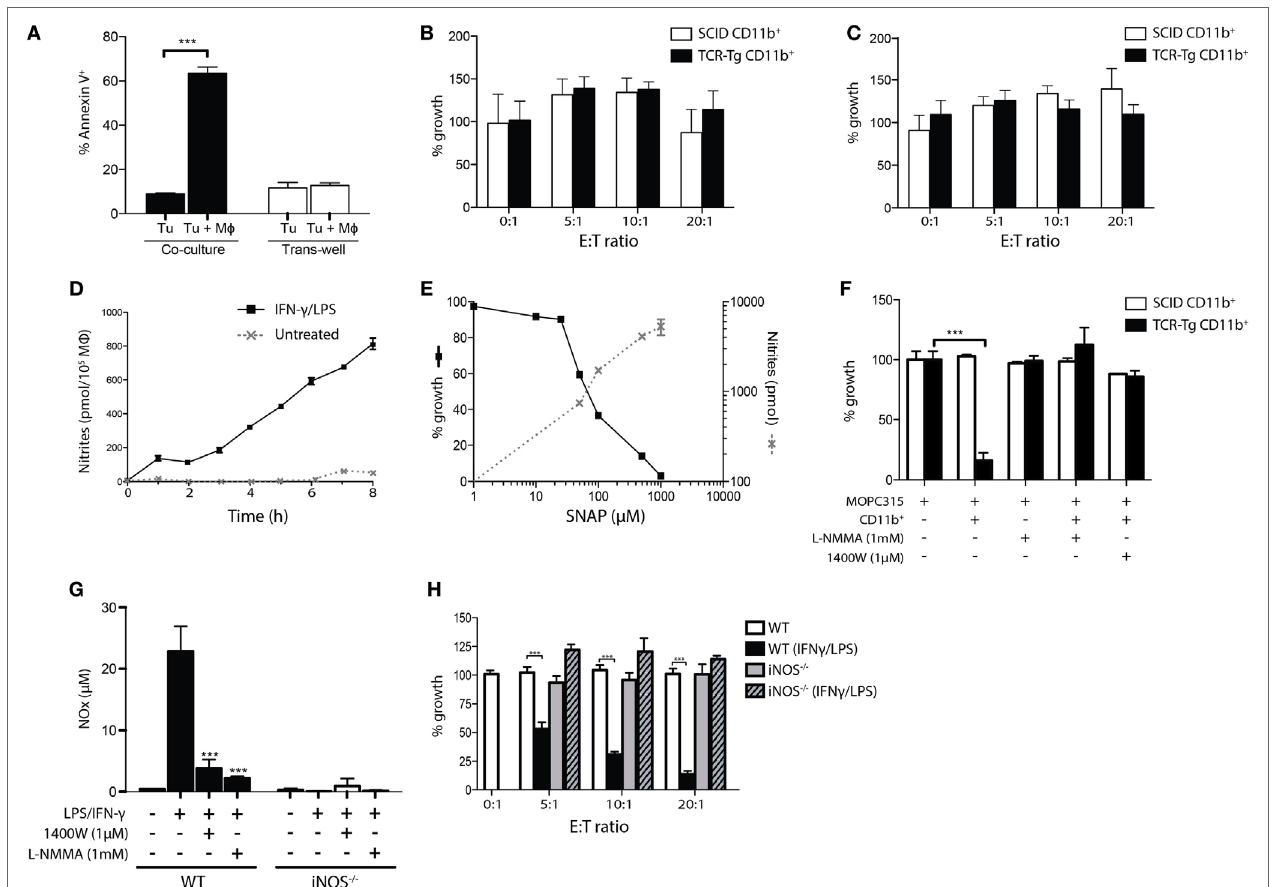
FigUre 2 | Killing of myeloma cells by activated macrophages is dependent on inducible nitric oxide synthase (iNOS)-mediated release of nitric oxide. (a) CD11b + cells were isolated from Matrigels at day + 12 following tumor challenge in T cell receptor-transgenic (TCR-Tg) mice, and co-incubated with tumor cells in co- culture or separated by a trans-well membrane at a 20:1 ratio. Surface exposure of Annexin V on tumor cells was determined after 24 h. (B,c) Cytotoxicity of glutaraldehyde-fixed Matrigel-derived CD11b + cells (B) and culture supernatant isolated after incubation of CD11b + cells (c) seeded at various ratios to tumor cells. Cells were incubated for 48 h with the addition of 3 H-thymidine for the last 18 h of culture. Growth was expressed as percentage counts per minute (cpm) of tumor cells cultured alone. (D) Accumulation of nitrites in supernatant of either interferon gamma (IFN- γ )/LPS-treated or untreated peritoneal macrophages was determined at various length of culture using the Griess assay. (e) MOPC315 tumor cell growth inhibition induced by the NO donor SNAP, plotted against the nitrite concentration at 4 h. (F) Tumor cell growth inhibition assay with CD11b + macrophages in the presence or absence of the NOS inhibitor L-NMMA or the selective iNOS inhibitor 1400W. Tumor-derived CD11b + cells from TCR-Tg or SCID mice at day + 12 following challenge were pre-treated for 2 h with the NOS inhibitors before the addition of tumor cells. After the 6 h co-incubation, tumor cells were washed and cultured for another 24 h with the addition of 3 H-thymidine for the last 18 h of culture (mean ± SD). (g) Griess assay showing NO release from in vitro cultured peritoneal macrophages from wild-type (WT) or iNOS-deficient (iNOS − / − ) mice. Macrophages were kept in a resting state or activated with IFN- γ /LPS and cultured in the presence or absence of the iNOS inhibitors 1400W or L-NMMA. Results are shown as mean + SD, with eight replicates per treatment condition. (h) Tumor cell growth inhibition assay showing the effects of co-culture of MOPC315 cells with resting or IFN- γ /LPS-activated peritoneal macrophages isolated from WT or iNOS-deficient (iNOS − / − ) BALB/c mice at the indicated ratios (mean ±